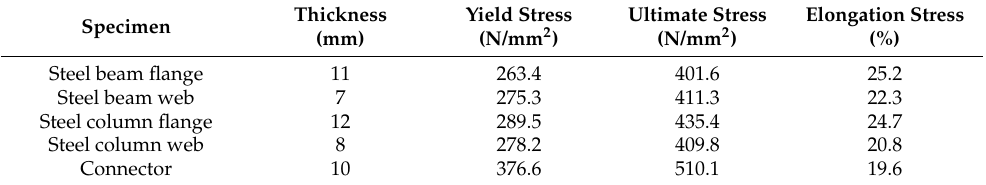
Table 3. Material properties of ALC panel.